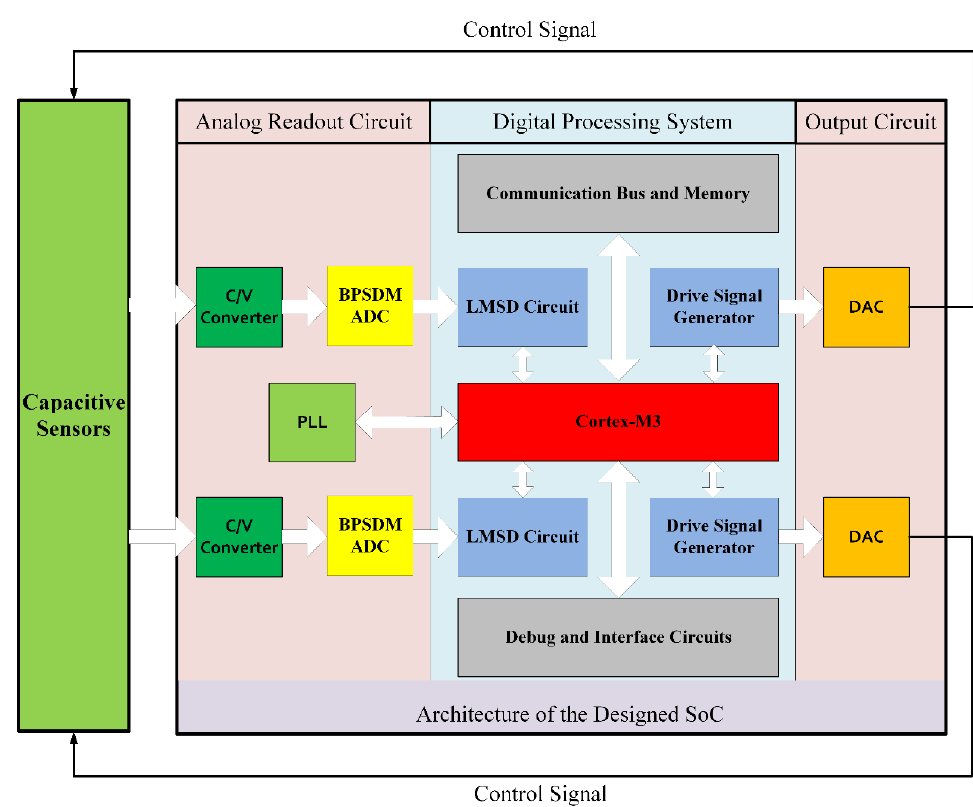
Figure 1. Architecture diagram of the SoC.